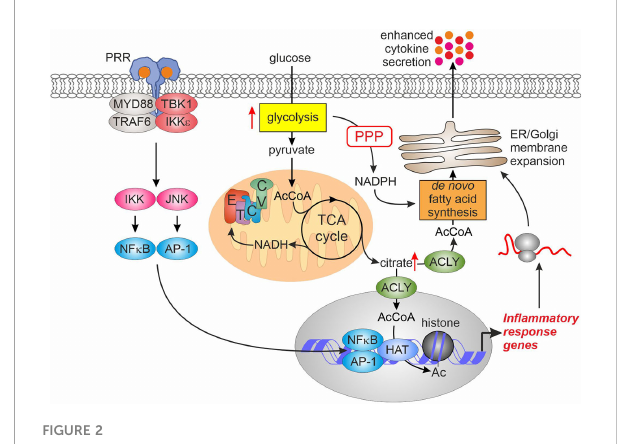
FIGURE 2 Glycolytic activation enhances in fl ammatory responses. Elevated glycolysis after PRR ligation enhances pyruvate entry into the TCA cycle. Consequently, this raises citrate export into cytosol